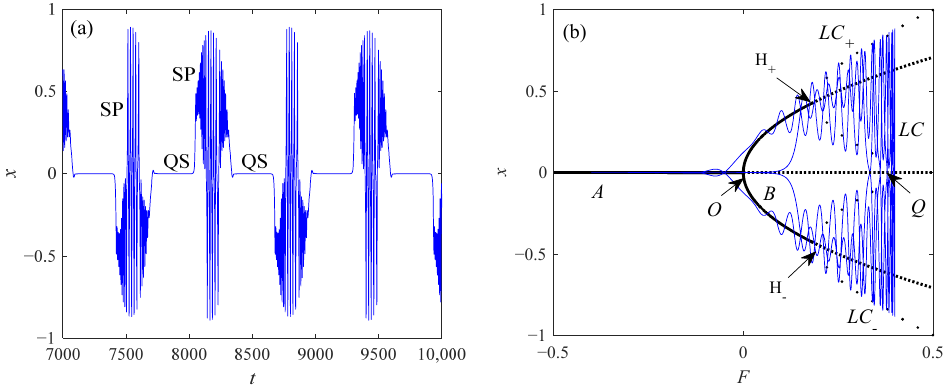
Figure 10. Cluster oscillation with β = 0.4. ( a ) Time history diagram. ( b ) Superposition of the transition phase diagram and bifurcation diagram on ( F , x )